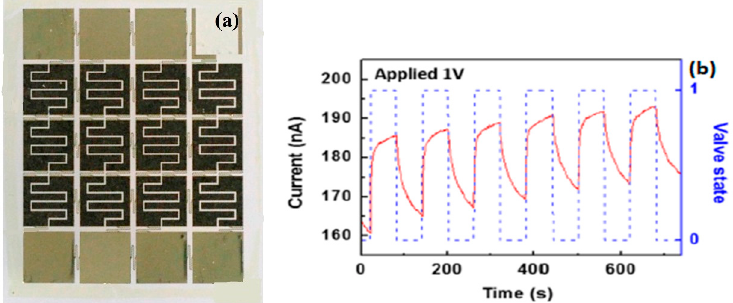
Figure 6. ( a ) Design concept of biaxially stretchable patterned-graphene sensor integrated with a MSC array; and ( b ) Current flow, induced by periodic exposure of 200 ppm NO 2 , through the graphene sensor operated by an external power supply of 1 V [62]. sensor operated by an external power supply of 1 V [62].